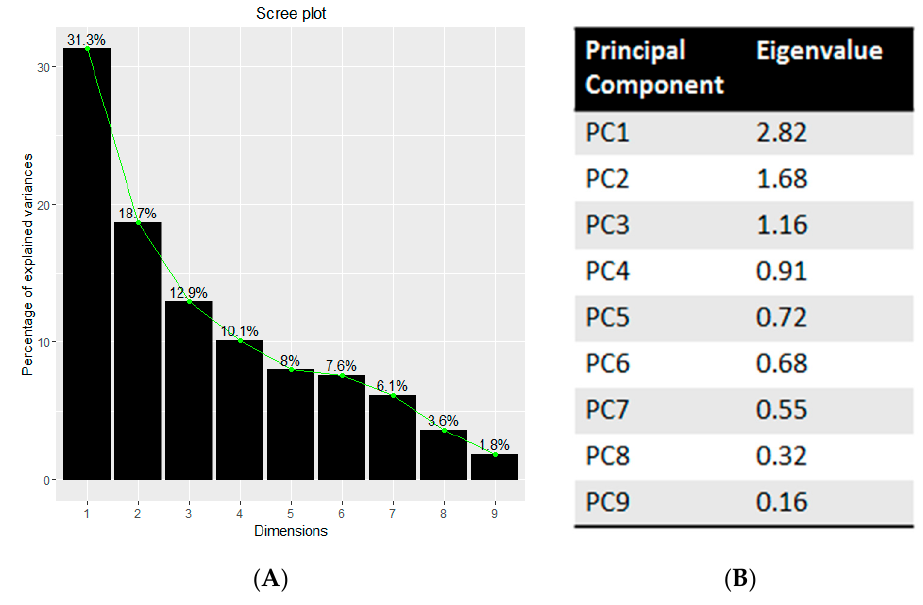
Figure 3. Eigenvalues ( A ) of the principal components and the relate scree plot ( B